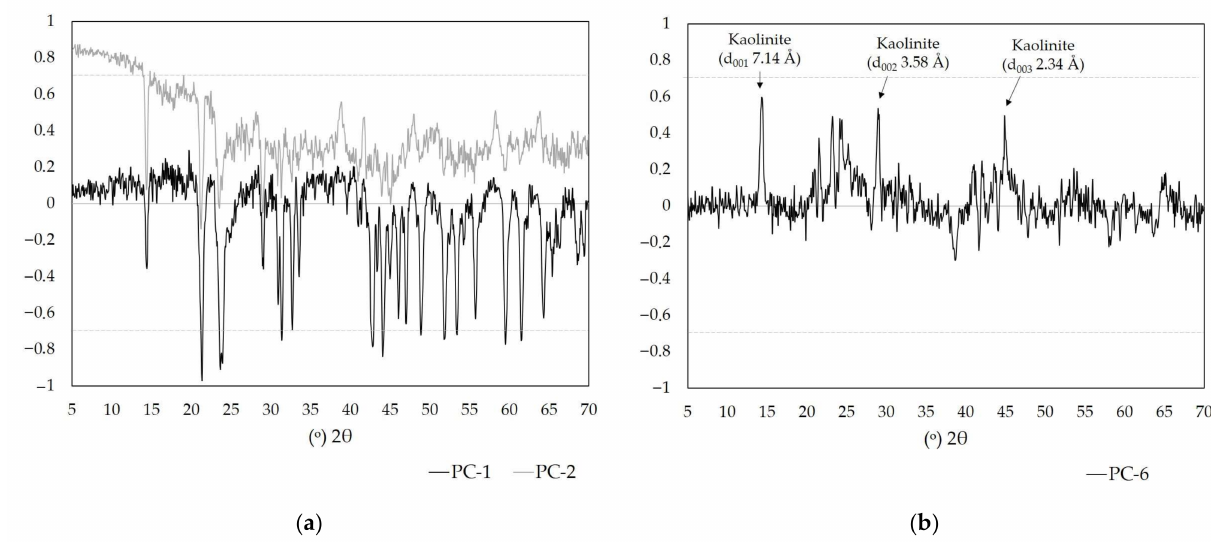
Figure 5. Linear-plot of PCA loadings: ( a ) PC-1 and PC-2; ( b ) PC-6. Dashed line represents 70% of the factors on the principal